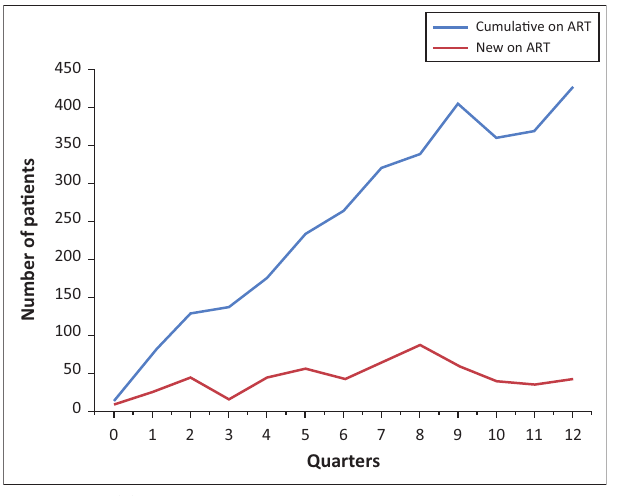
ART, antiretroviral therapy. FIGURE 1: Mlandizi Health Centre patients, new and cumulative on antiretroviral therapy by quarter.